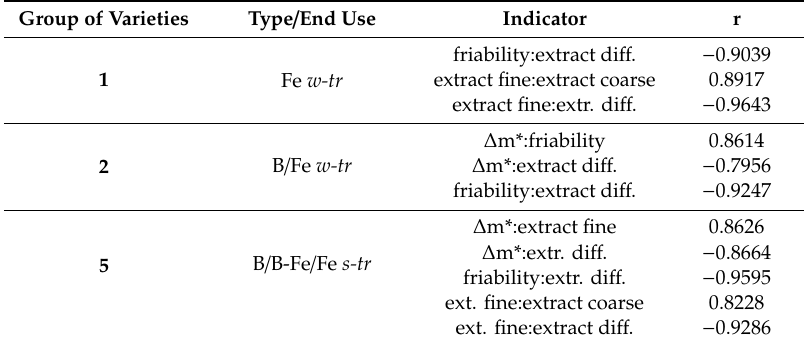
Table 6. Statistically significant correlation between the established quality indicators of malt and β -glucan loss from barley to malt ( ∆ m*) for di ff erent end use varieties (Pearson correlation matrix). Group of Varieties Type / End Use Indicator r friability:extract di ff . − 0.9039 extract fine:extract coarse 0.8917 1 Fe w-tr extract fine:extr. di ff . − 0.9643 ∆ m*:friability 0.8614 ∆ m*:extract di ff . − 0.7956 2 B / Fe w-tr friability:extract di ff . − 0.9247 ∆ m*:extract fine 0.8626 ∆ m*:extr. di ff . − 0.8664 5 B / B-Fe / Fe s-tr friability:extr. di ff . − 0.9595 ext. fine:extract coarse ext. fine:extract di ff